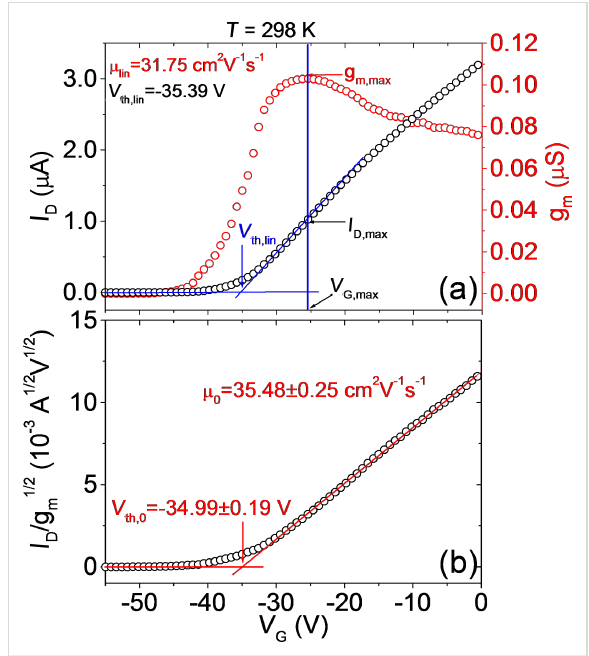
Figure 4b. The corrected value of the field effect